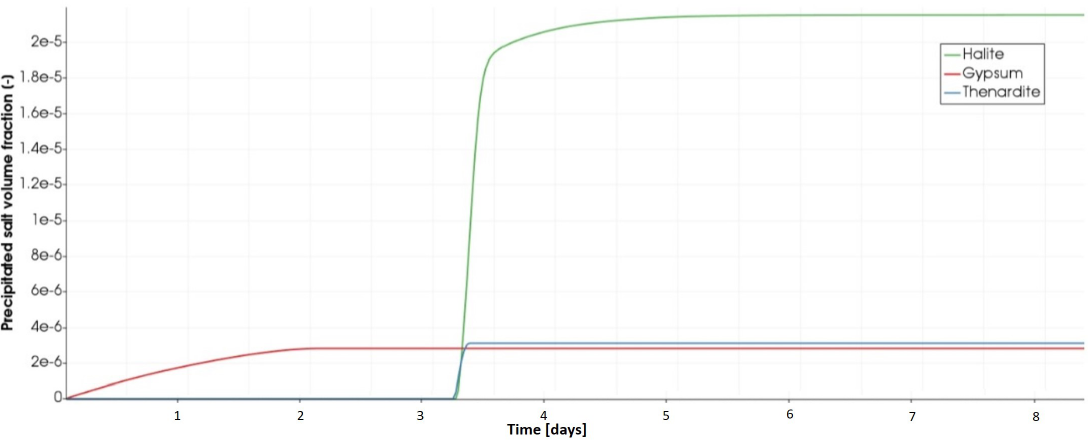
Figure 13. Variation of the volume of the precipitated salts at the evaporating surface at the top of the porous